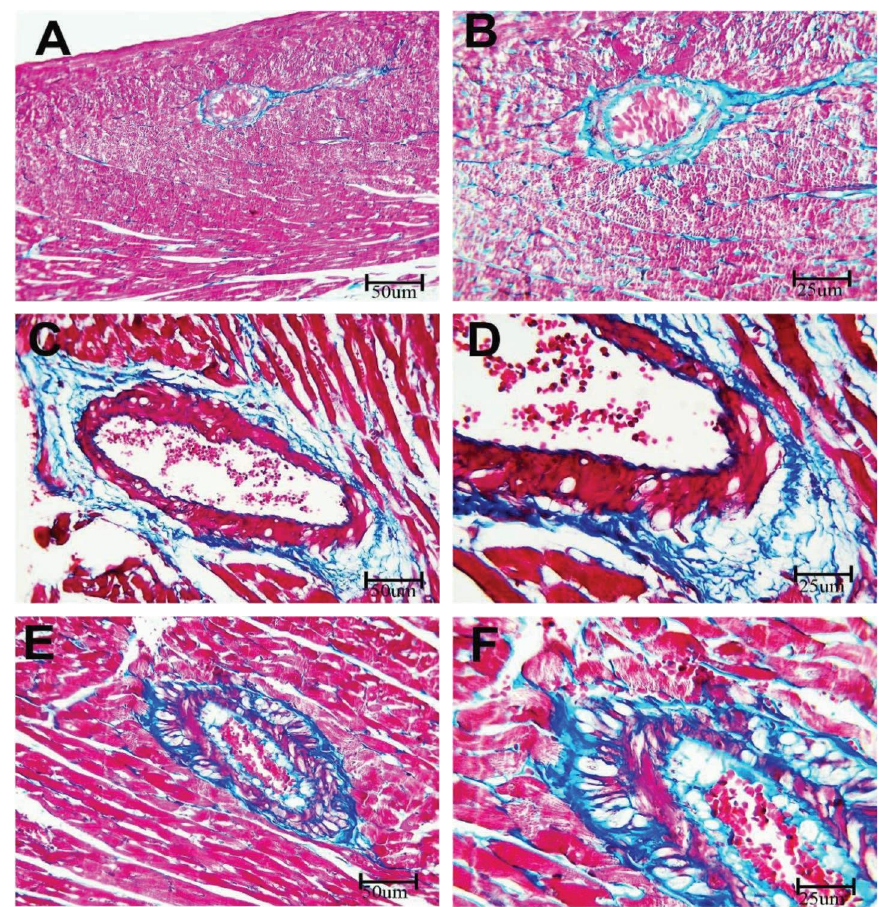
Figure 3: Histopathological section in the coronary of rat stained with Masson trichrome stain. a and b are the control group, c and d are the BPA group, and e and f are the BPA+ LC group. Te coronary artery of the control group shows minimal bluish-stained collagen fber in the wall of the artery. Te expression of the color is notably increased in the BPA group and reduced in the BPA +LC group (Masson trichrome stain; A, C, and E X 200; B, D, and F X 400). Table 1: Comparison between the study groups regarding Masson trichrome area fraction (%), caspase area fraction (%), and eNOS area fraction